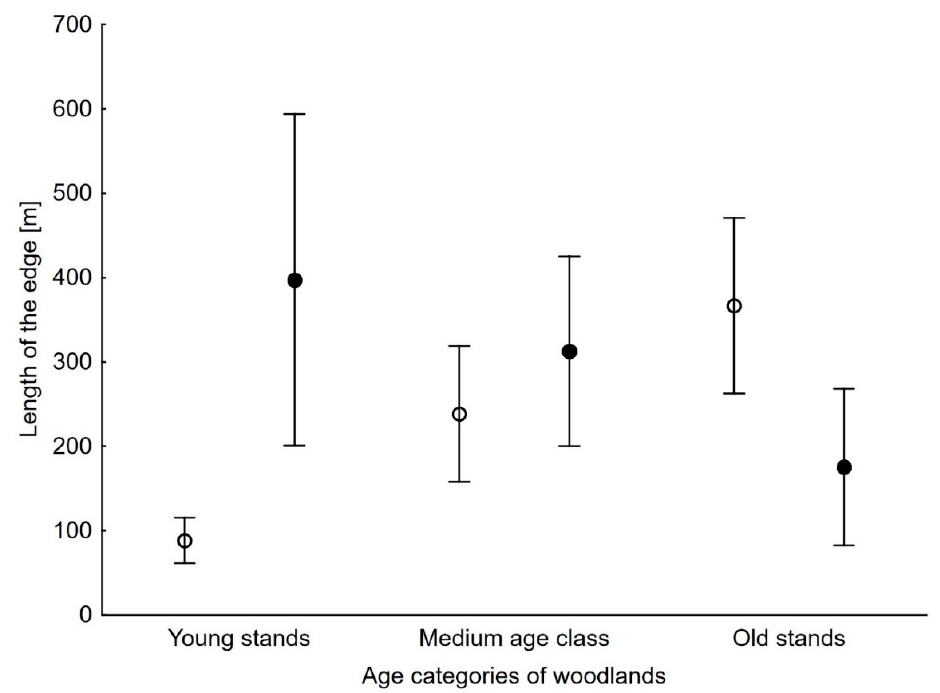
Figure 2. Mean values (points) and 95% confidence limits (whiskers) of edge lengths of tree stands in three age categories bordering unoccupied clearings (open circles) and Nightjar territories (black circles).